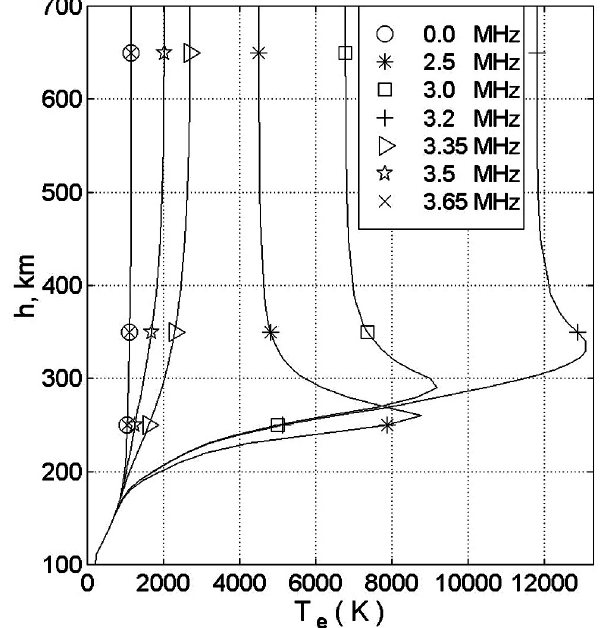
Fig. 3. Profiles of the electron temperature versus distance from the Earth along the geomagnetic field line situated in the illuminated region at S = 55 . 89km. The results are given for different HF wave frequencies: 2.5, 3.0, 3.2, 3.35, 3.5, and 3.65MHz, with sym- bol 0MHz indicating the results obtained under natural conditions without